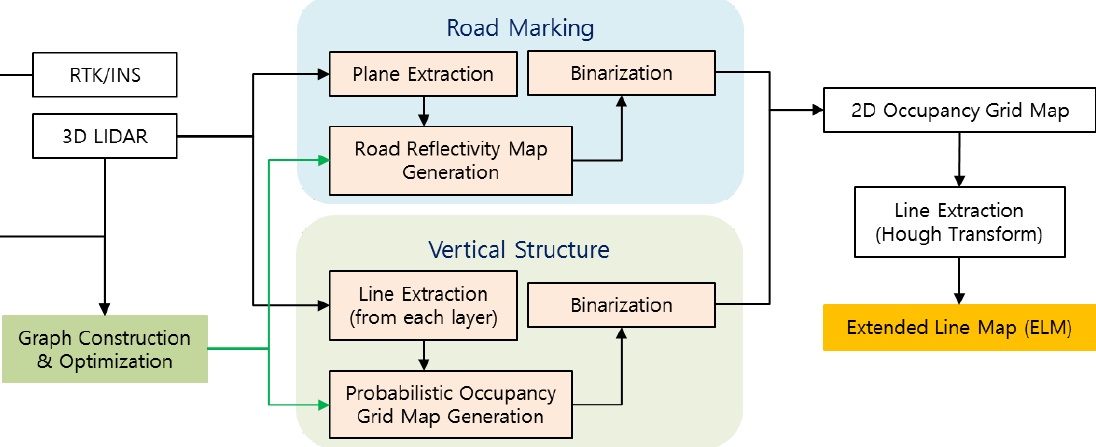
Figure 1. Extended line map (ELM) generation process.